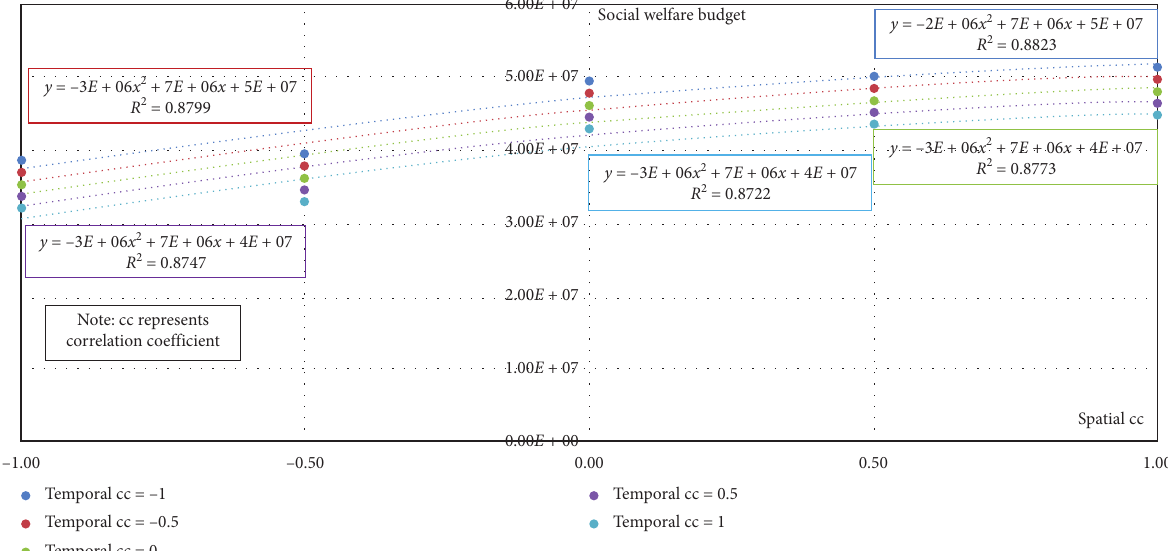
Figure 4: The effects of space-time correlation of population densities on social welfare budget for the Western Island